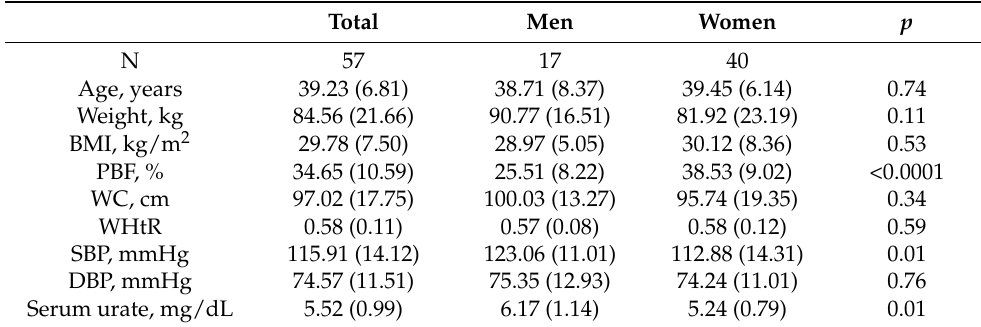
Table 1. Study participants characteristics at